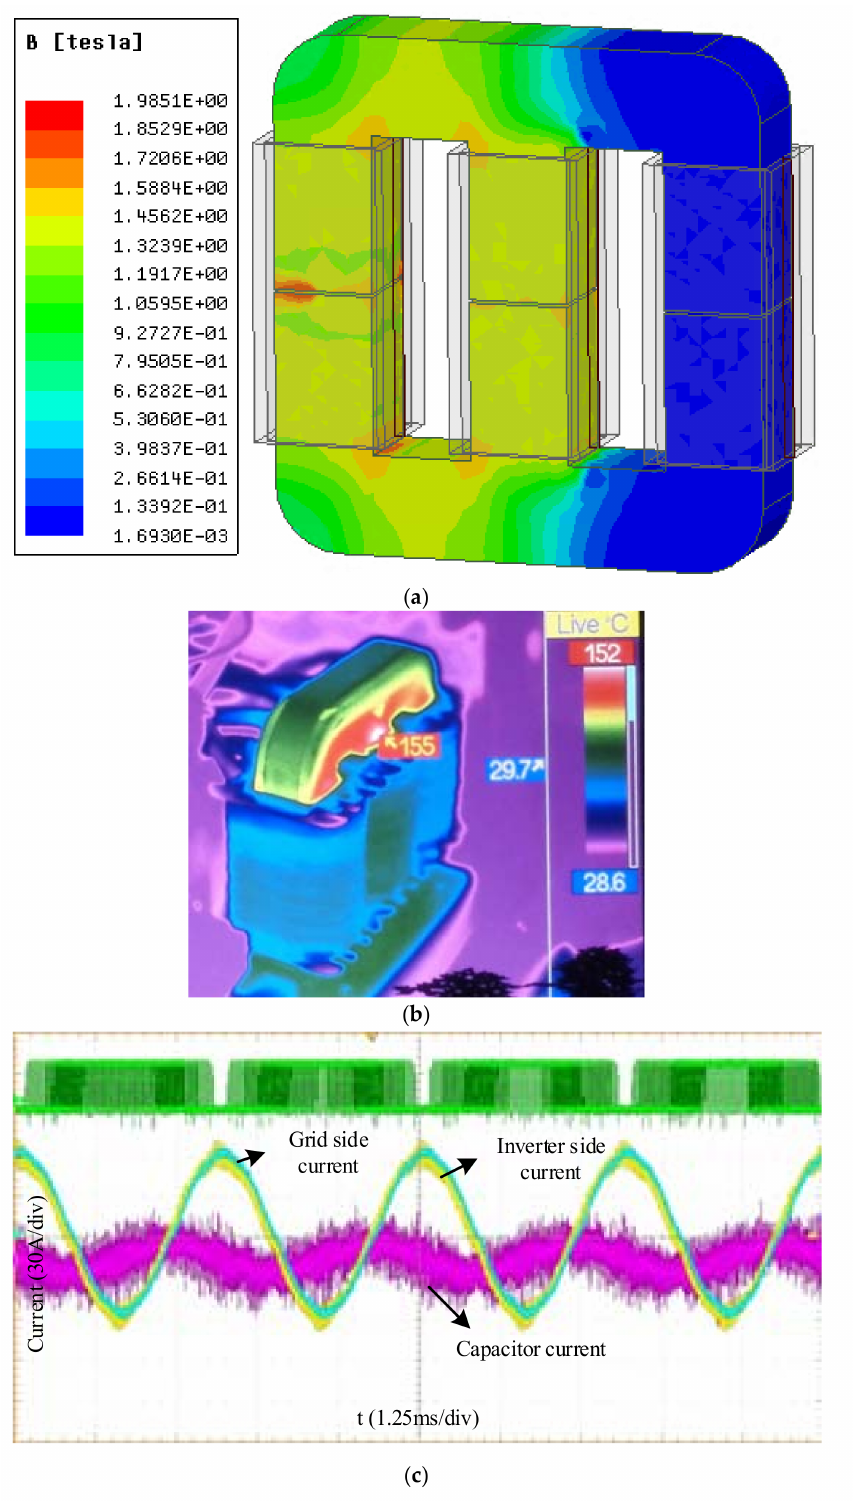
Figure 11. ( a ) FEA analysis for flux distribution; ( b ) inductor temperature distribution; ( c ) currents of the inverter and grid